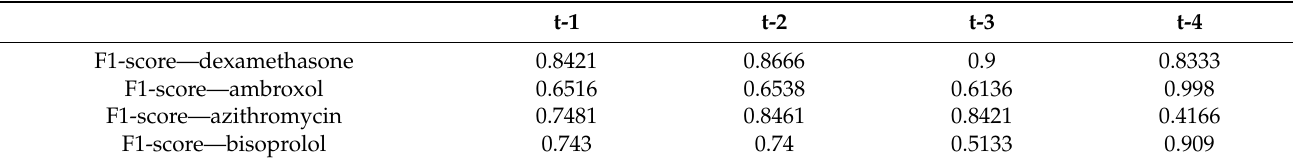
Table 6. Metrics of DBN predictions facts of prescribing drugs in different time intervals.